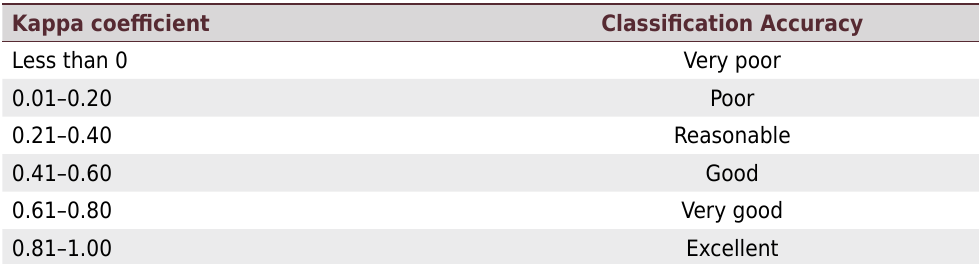
Table 2. Image quality classification according to kappa index ranges Kappa